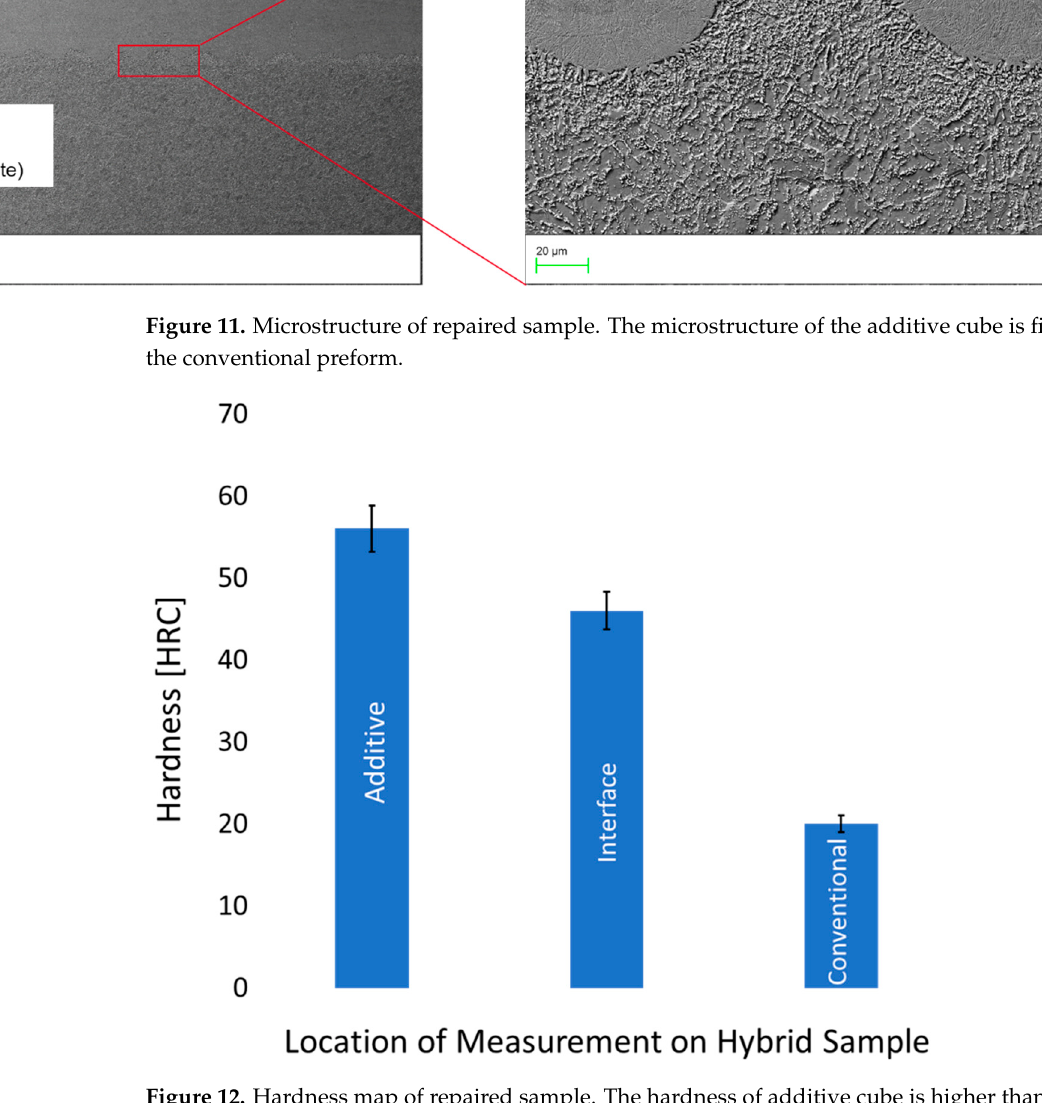
Figure 12. Hardness map of repaired sample. The hardness of additive cube is higher than conven- tional. The interface hardness lies between additive and conventional.